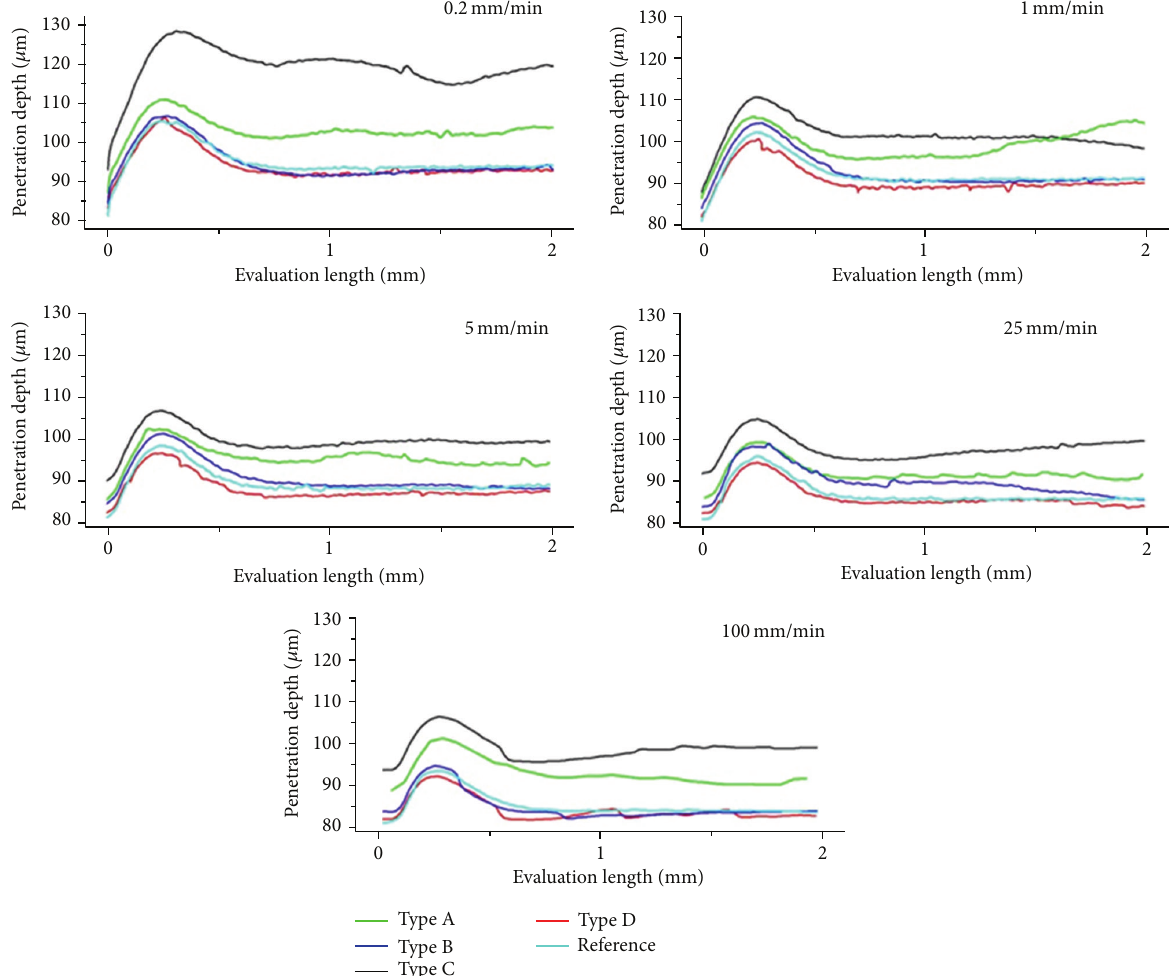
Figure 7: Penetration depth in scratch tests at constant load and different sliding